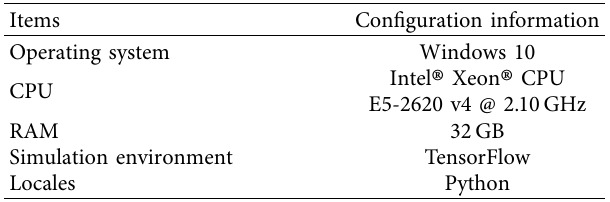
Table 1: Configuration of numerical experiment. Table 2: Settings for the four